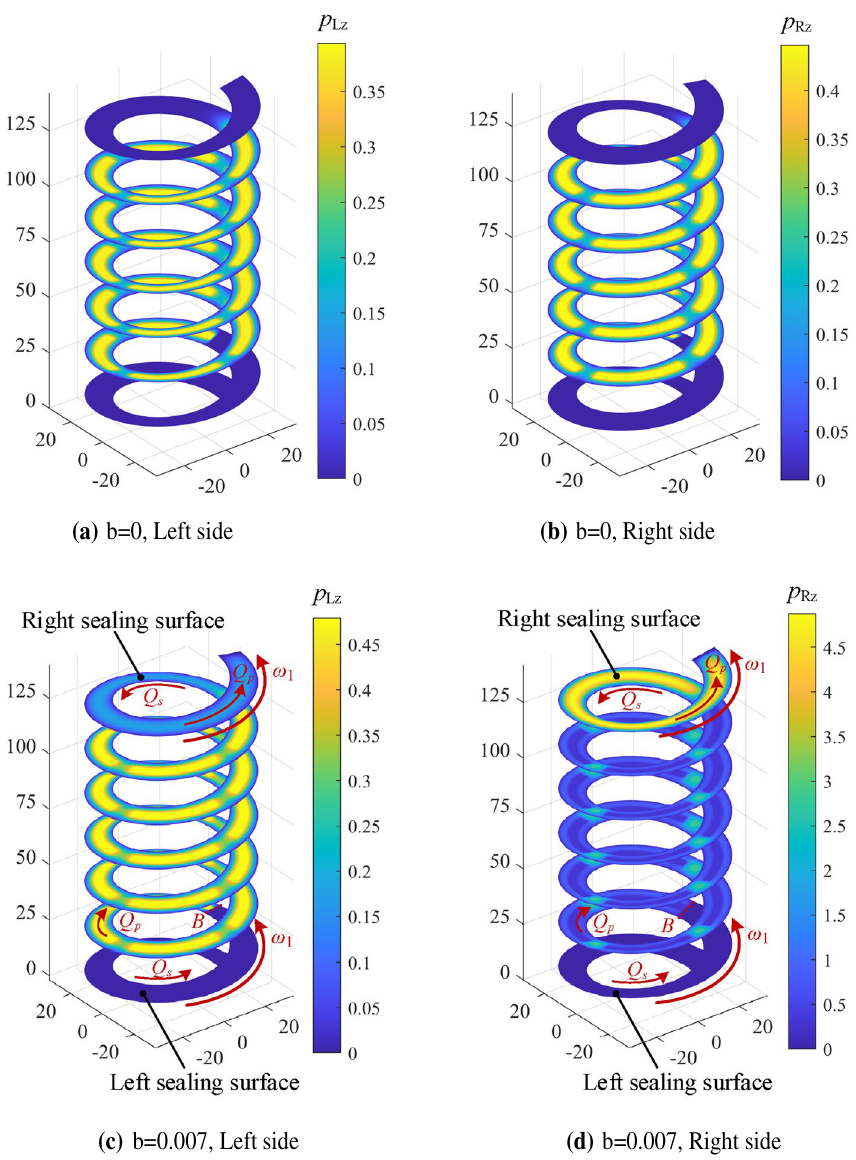
Figure 13. Disturbance pressure distribution under the influence of Δ z when ω 1 = 9000 rpm, ω 2 = 0 rpm, Δ h = 0.5 h